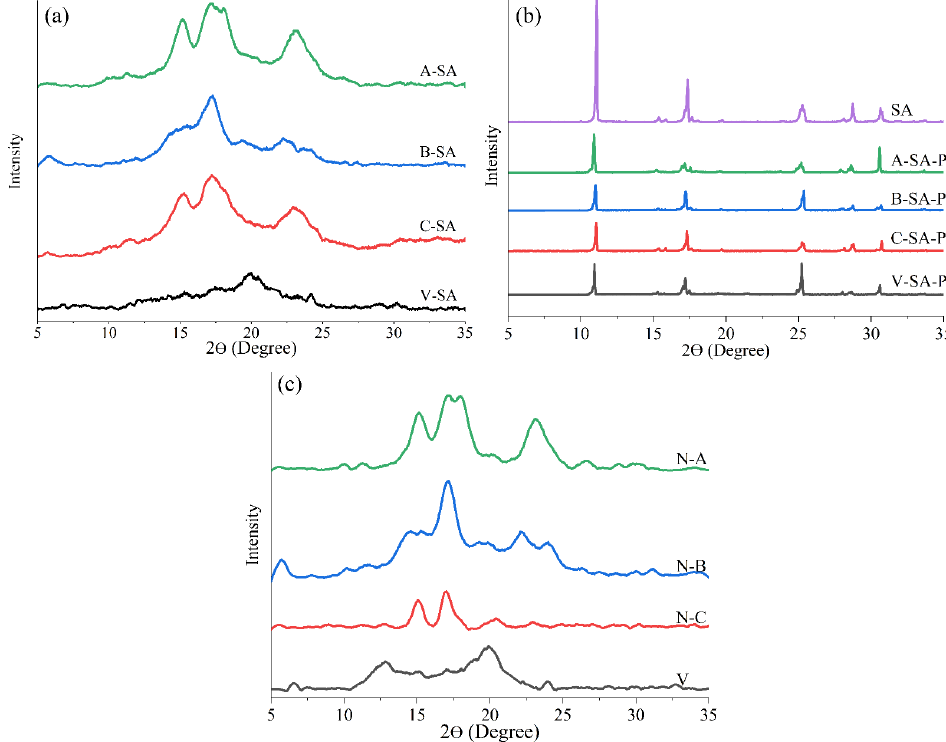
Figure 5. X–ray patterns of the ( a ) four inclusions, ( b ) SA and corresponding physical mixtures, and ( c ) four crystal types of native starches. ( c ) four crystal types of native